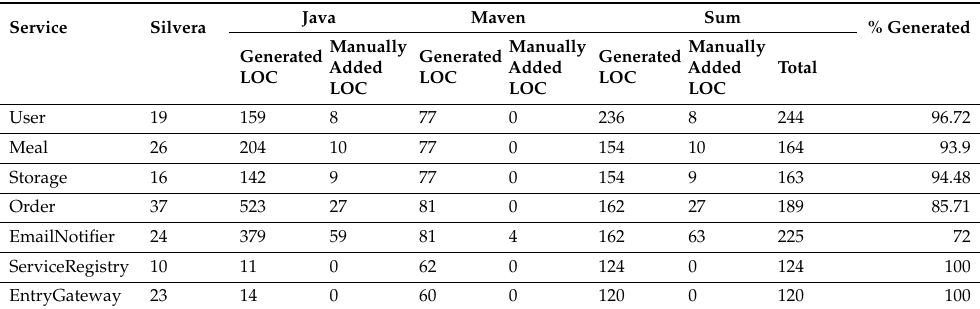
Table 12. The comparison of the number of automatically generated lines of code and manually written lines of code for the Eat and Drink